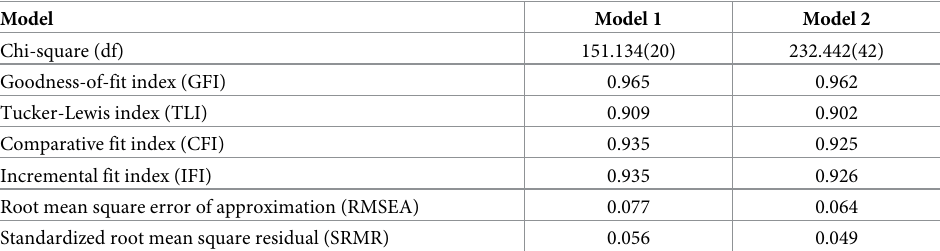
Table 2. Fit indices of proposed